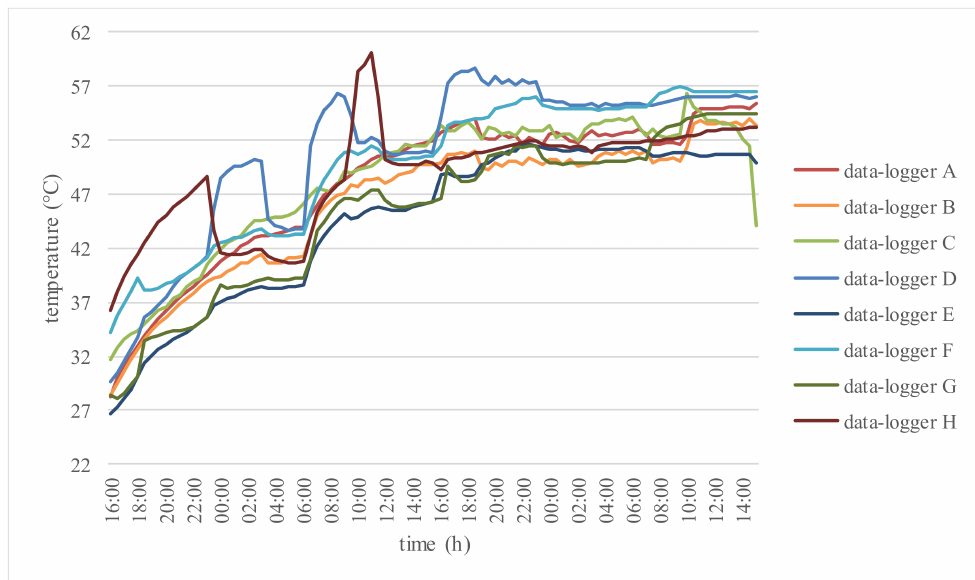
Figure 6. Indoor air temperature detected by the temperature probes during heat treatment